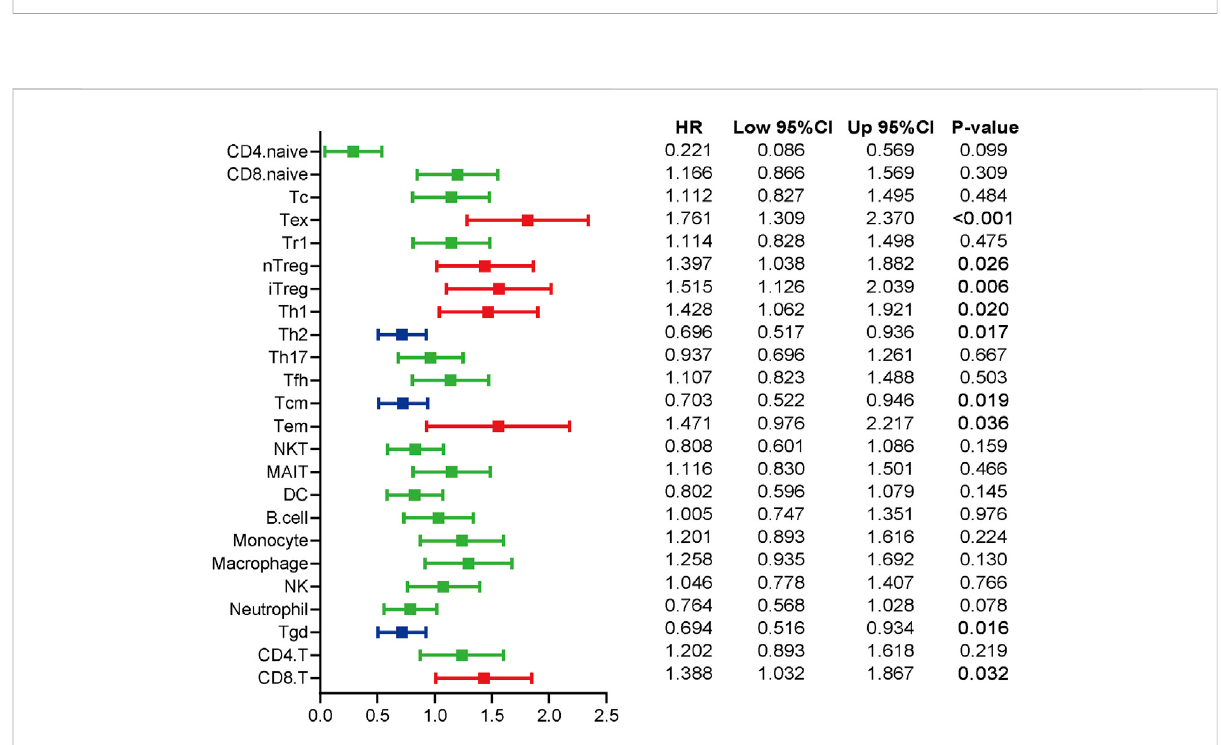
FIGURE 3 The correlation and proportion of TIICs in ccRCC. (A) Correlation matrix of24 TIICs in ccRCC samples. Red represents positive correlation, and blue represents negative correlation. Signi fi cance was calculated with Pearson correlation analysis. (B) The proportion of 24 TIICs in ccRCC.